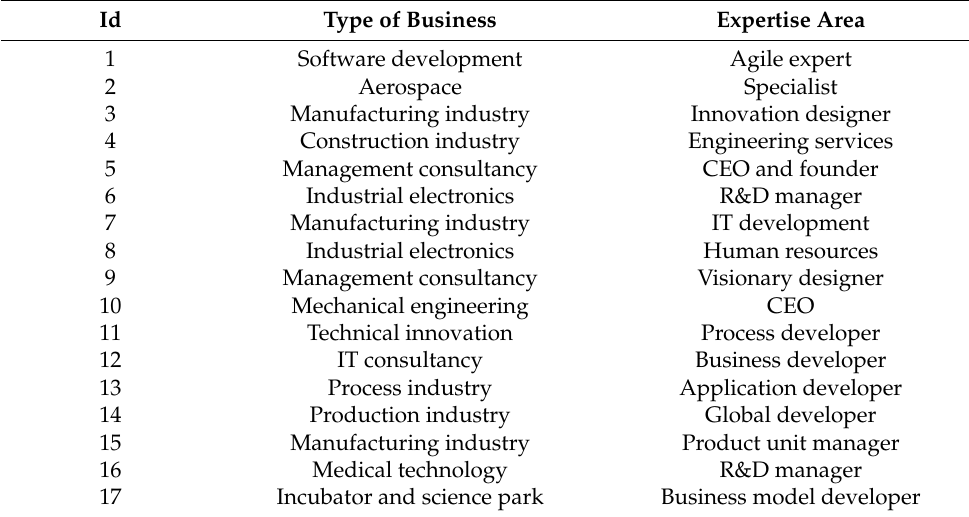
Table 1. Overview of the businesses and positions of the